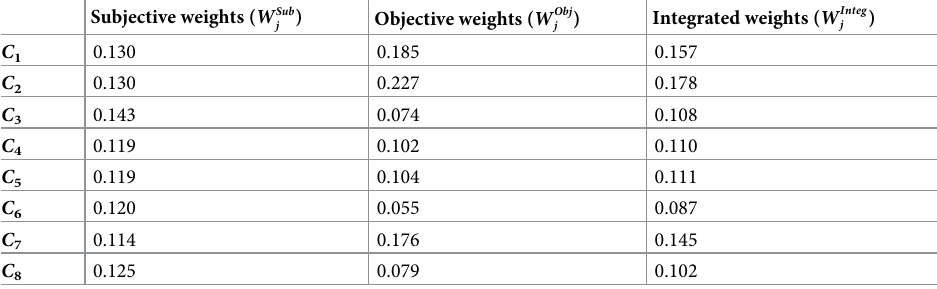
Table 10. Integrated weights of